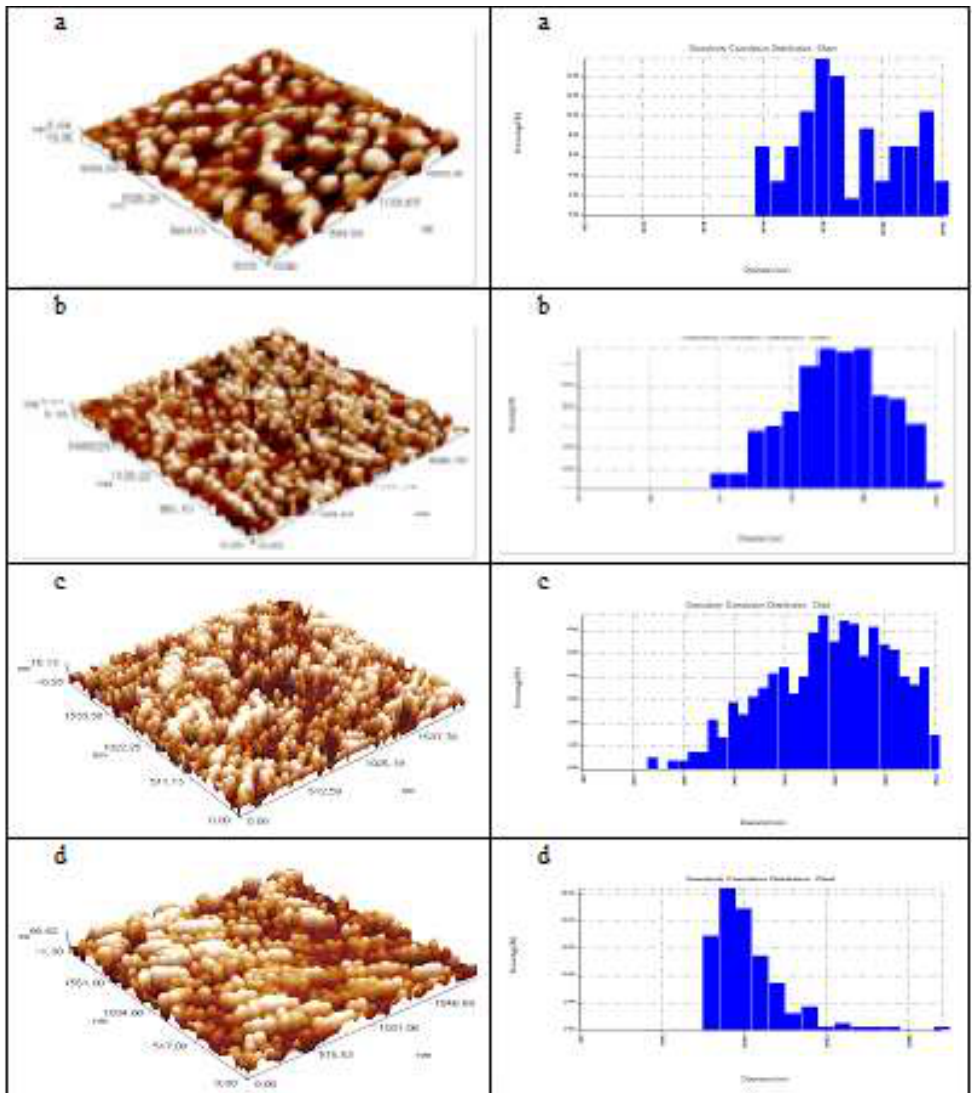
Figure (4): AFM images at 3D of vanadium pentoxide and tin dioxide at different temperatures Table (2): Average grain size of nanoparticles of V 2 O 5 and SnO 2 at (90 °C and 500